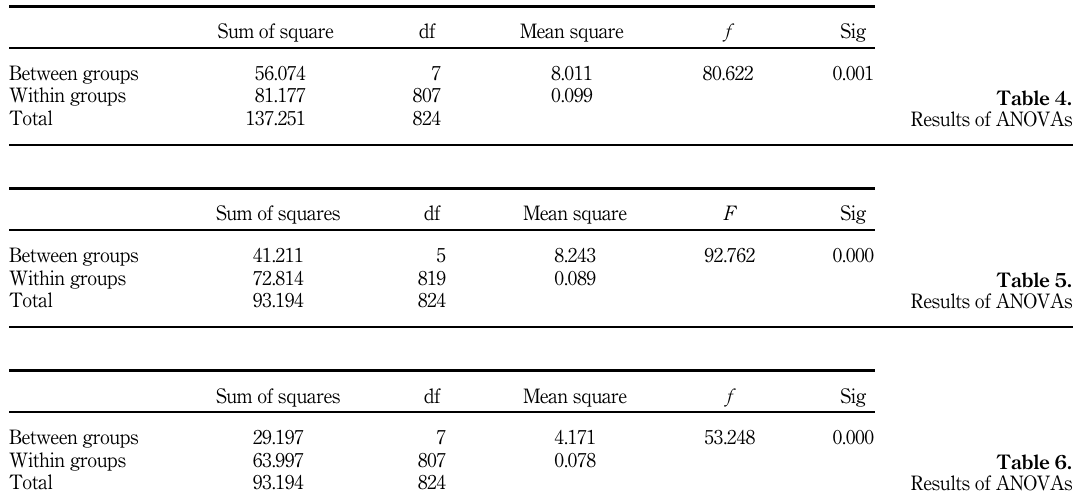
Table 6. Results of